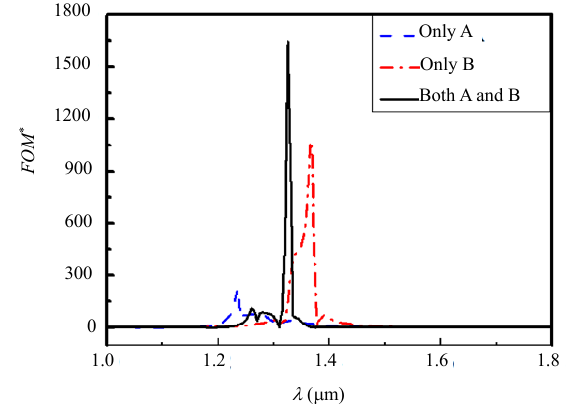
Fig. 7 Calculated FOM * at different wavelengths for rectangular cavity A (blue dashed line) and rectangular cavity B (red dotted line), and both rectangular cavities A and B are considered (black solid